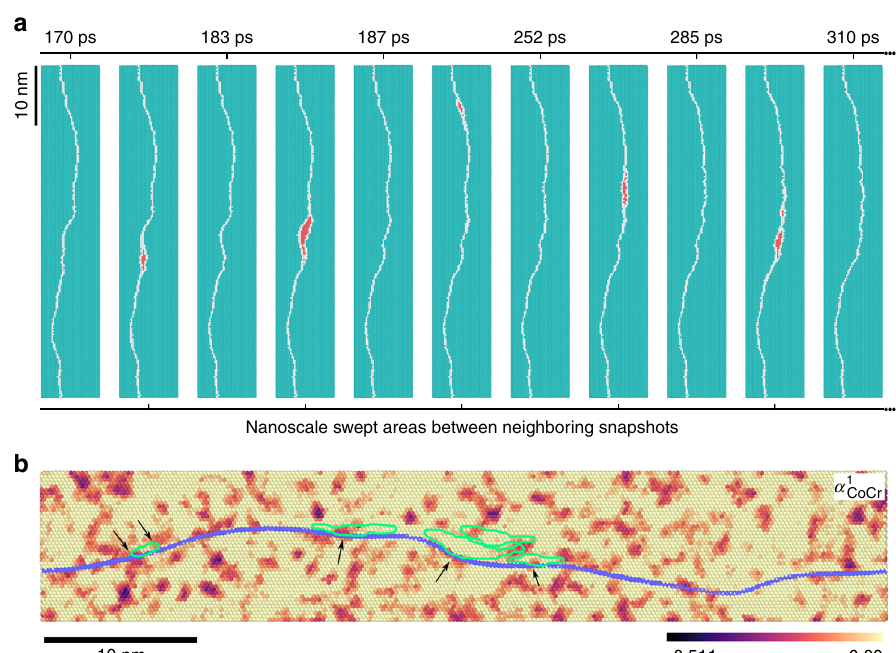
Fig. 6 Nanoscale segment detrapping in random solid solution of NiCoCr. a Dislocation line morphology evolution under a shear stress of 50 MPa at 300 K. The several swept areas are highlighted in red. b Correlation between nanoscale segment detrapping events and spatial deviations from chemical disorder. Atoms are colored according to the coarse-grained α 1 ; darker color means stronger Cobalt-Chromium (Co – Cr) short-range-order (more negative α 1 CoCr The swept areas in a are now outlined in green. These activated nanoscale segments are seen to detrap from some of the local hard regions that have stronger Co – Cr local chemical ordering (LCO) (as denoted by the arrows) and then propagate into local regions without such chemical order. It is not expected that our speci fi c loading conditions within the short simulation period would be able to activate all the segments at LCO trapping sites. For some of the regions with weak Co – Cr LCO along the dislocation line, thermal activation is expected to have already moved those segments, producing a wavy dislocation line before loading, when the sample was fi rst relaxed at 300 K for 100 ps. Continued bow-out increasing curvatures is limited by the line